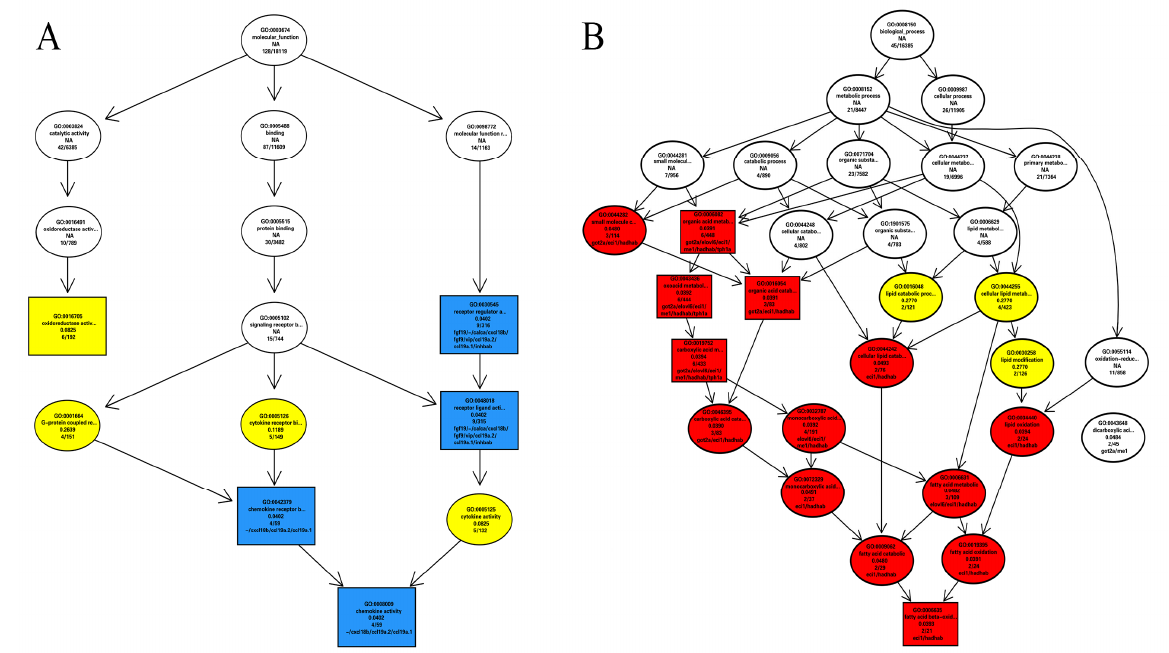
Figure 2. DEGs in BPs ( A ) and MF ( B ). The rectangle represents GO with the enrichment level of TOP5, and the oval is non-Top5. The shade of color expresses the degree of enrichment. In ( A ), blue represents the strongest enrichment, followed by yellow and white representing the weakest enrichment. In ( B ), red represents the strongest enrichment, followed by yellow and white representing the weakest enrichment.